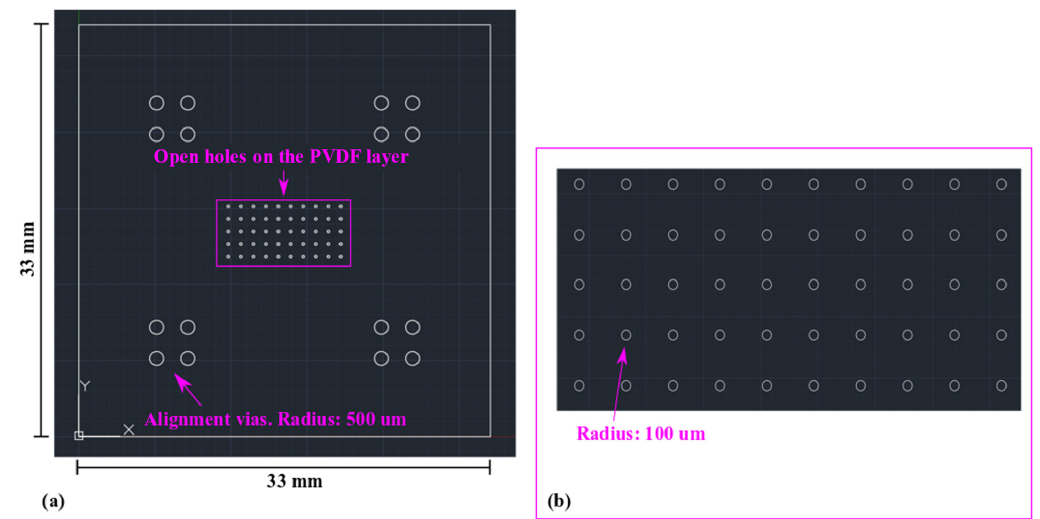
Figure 9. Mass sensor piezoelectric PVDF layer laser micromachining mask. ( a ) Overall view. ( b ) Zoom-in view of the circular open windows.